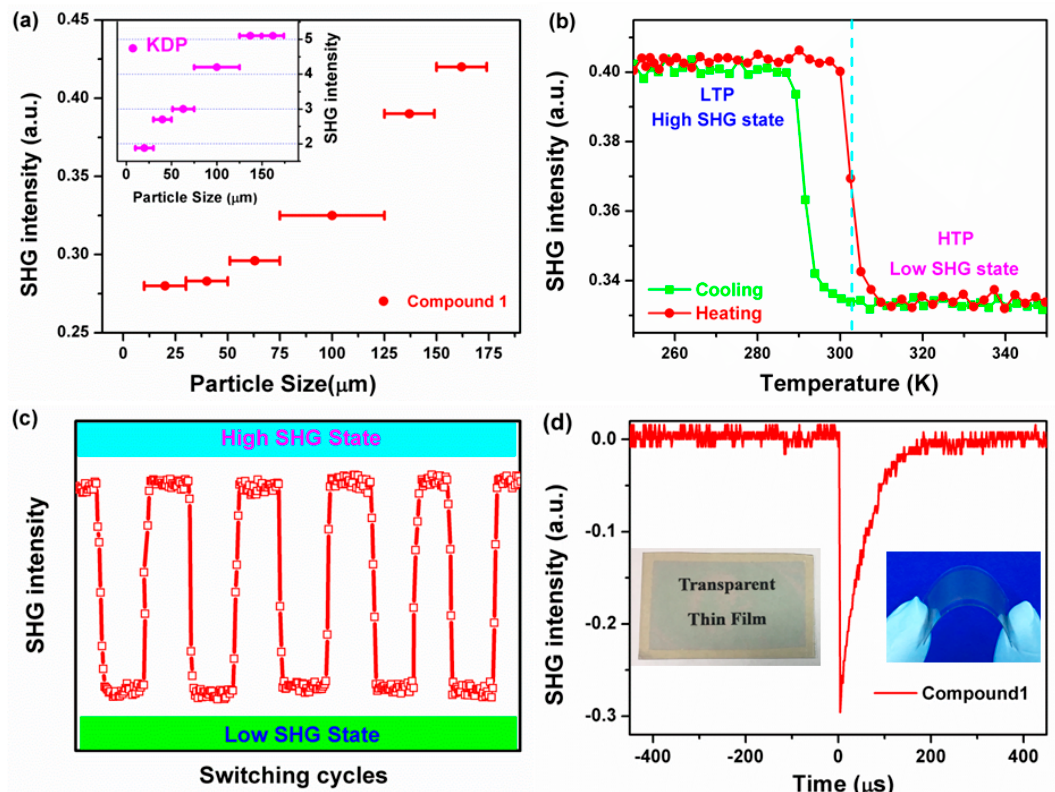
Figure 4. ( a ) Particle size versus second harmonic generation (SHG) intensity data of the 1 and KH 2 PO 4 (KDP) single crystal at 298 K. ( b ) Temperature dependency of SHG effects of 1 in the heating run at the 125 µ m particle size. ( c ) The NLO switching trajectory from high- to low-state of 1 . ( d ) Oscilloscope trace of the SHG of thin film. Inset: flexibility of the thin film.